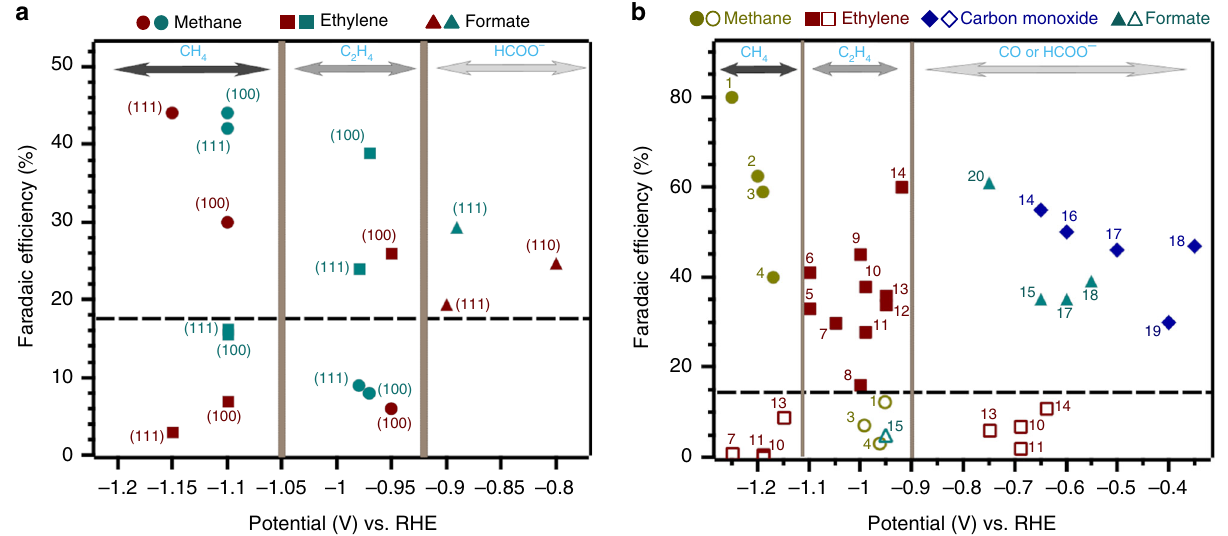
Fig. 4 Potential windows for the selective formation of different products. a Faradaic ef fi ciency of ethylene, methane, and formate on different copper single crystals at different potentials from ref. 43 (wine) and ref. 44 (cyan). b The selectivities of 20 different Cu catalysts reported by 11 different research groups at different applied potentials. (1) isolated particles — ref. 7 ; (2) Cu-10 in this work; (3) polycrystalline — ref. 9 ; (4) polycrystalline — ref. 4 ; (5) Cu 2 O (3 C cm − 2 ) — ref. 8 ; (6) 44 nm cubes — ref. 47 ; (7) nanoparticles — ref. 45 ; (8) KF roughened Cu — ref. 46 ; (9) electrochemically cycled Cu — ref. 31 ; (10) Cu μ m) — ref. 9 ; (11) mesocrystals — ref. 40 ; (12) CuO-10 in this work; (13) nanocrystals (Cu-NC10) — ref. 45 ; (14) Cu nanocrystals (Cu-NC20) — ref. 45 ; (16) CuO nanowire — ref. 6 ; (17) CuO-60 in this work; (18) Cu 2 O (annealing) — ref. 5 ; (19) Cu 2 O (11 C cm -2 ) — ref. 8 ; (20) CuO nanoparticles — ref.